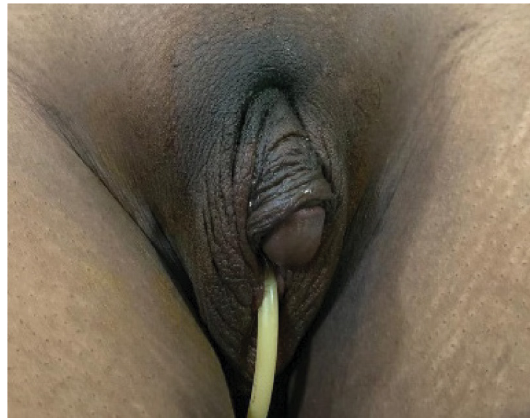
Figure 1C: Foley’s Catheterization in the urethral opening, below